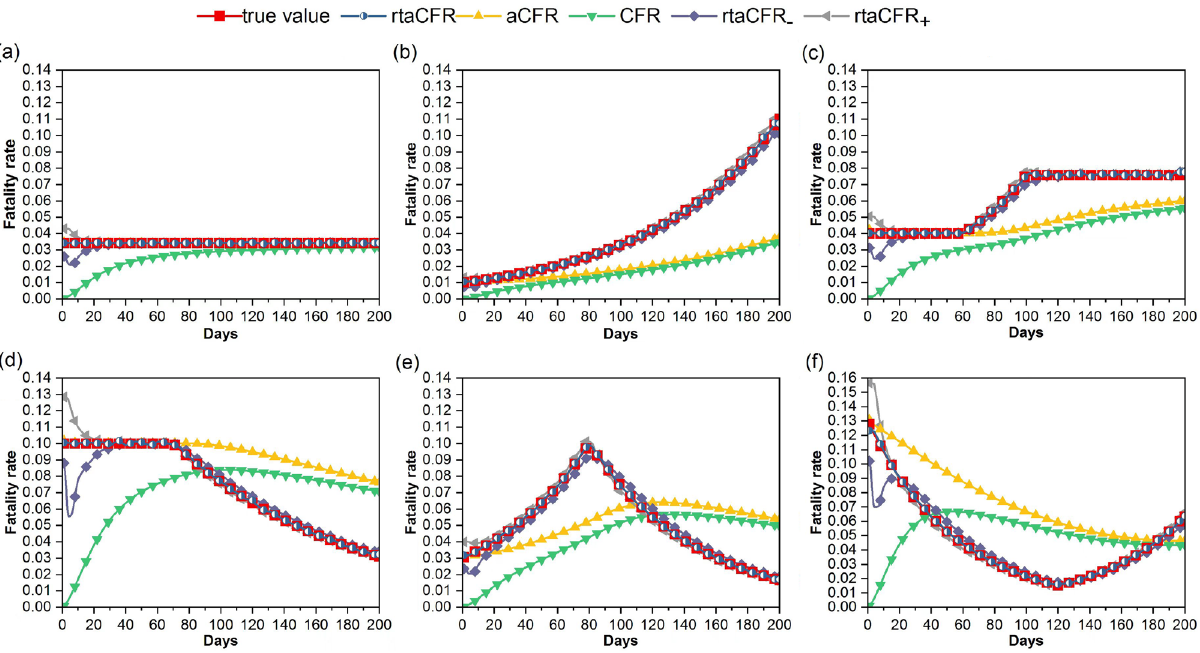
Figure 1. Performance of the proposed real-time fatality rate estimator (rtaCFR) ( rtaCFR − and rtaCFR + are for robustness check) compared with the traditional case fatality rate (CFR) and the time-delay adjusted case fatality rate (aCFR) under different hypothetical scenarios of true values based on 1000 replicates. The true values are ( a ) p ( t ) = 0.034 ; ( b ) p ( t ) = 0.01 · e 0.012 t ; ( c ) 0.04 · e 0.016 · I ( t > 60 ) · min ( 40, t − 60 ) ; ( d ) 0.1 · e − 0.009 · ( t − 70 ) · I ( t > 70 ) ; ( e ) 0.1 · e − 0.015 ·| t − 80 | ; and ( f ) 0.015 · e 0.018 ·| t − 120 | for t = 1, . . . , 200